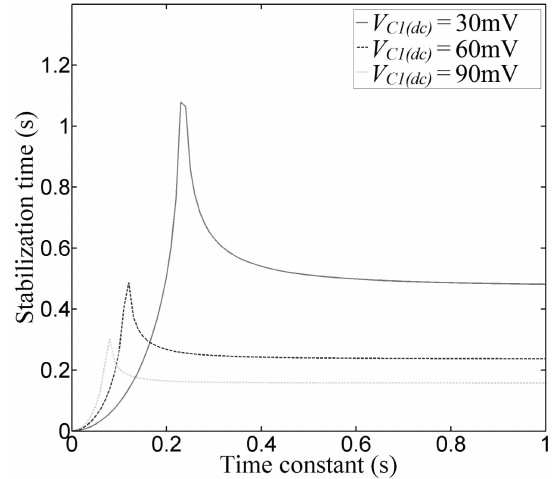
Figure 9. Stabilization time vs time constant plot. The stabilization time reaches its maximum value when the time constant is equal to τ ( min ). For all values of τ lower than τ ( min ), the stabilization time results in an imaginary value, it means that an unstable state in which the system (flame detector sensor) outputs a rectangular wave always. For large τ values, the stabilization time remains practically